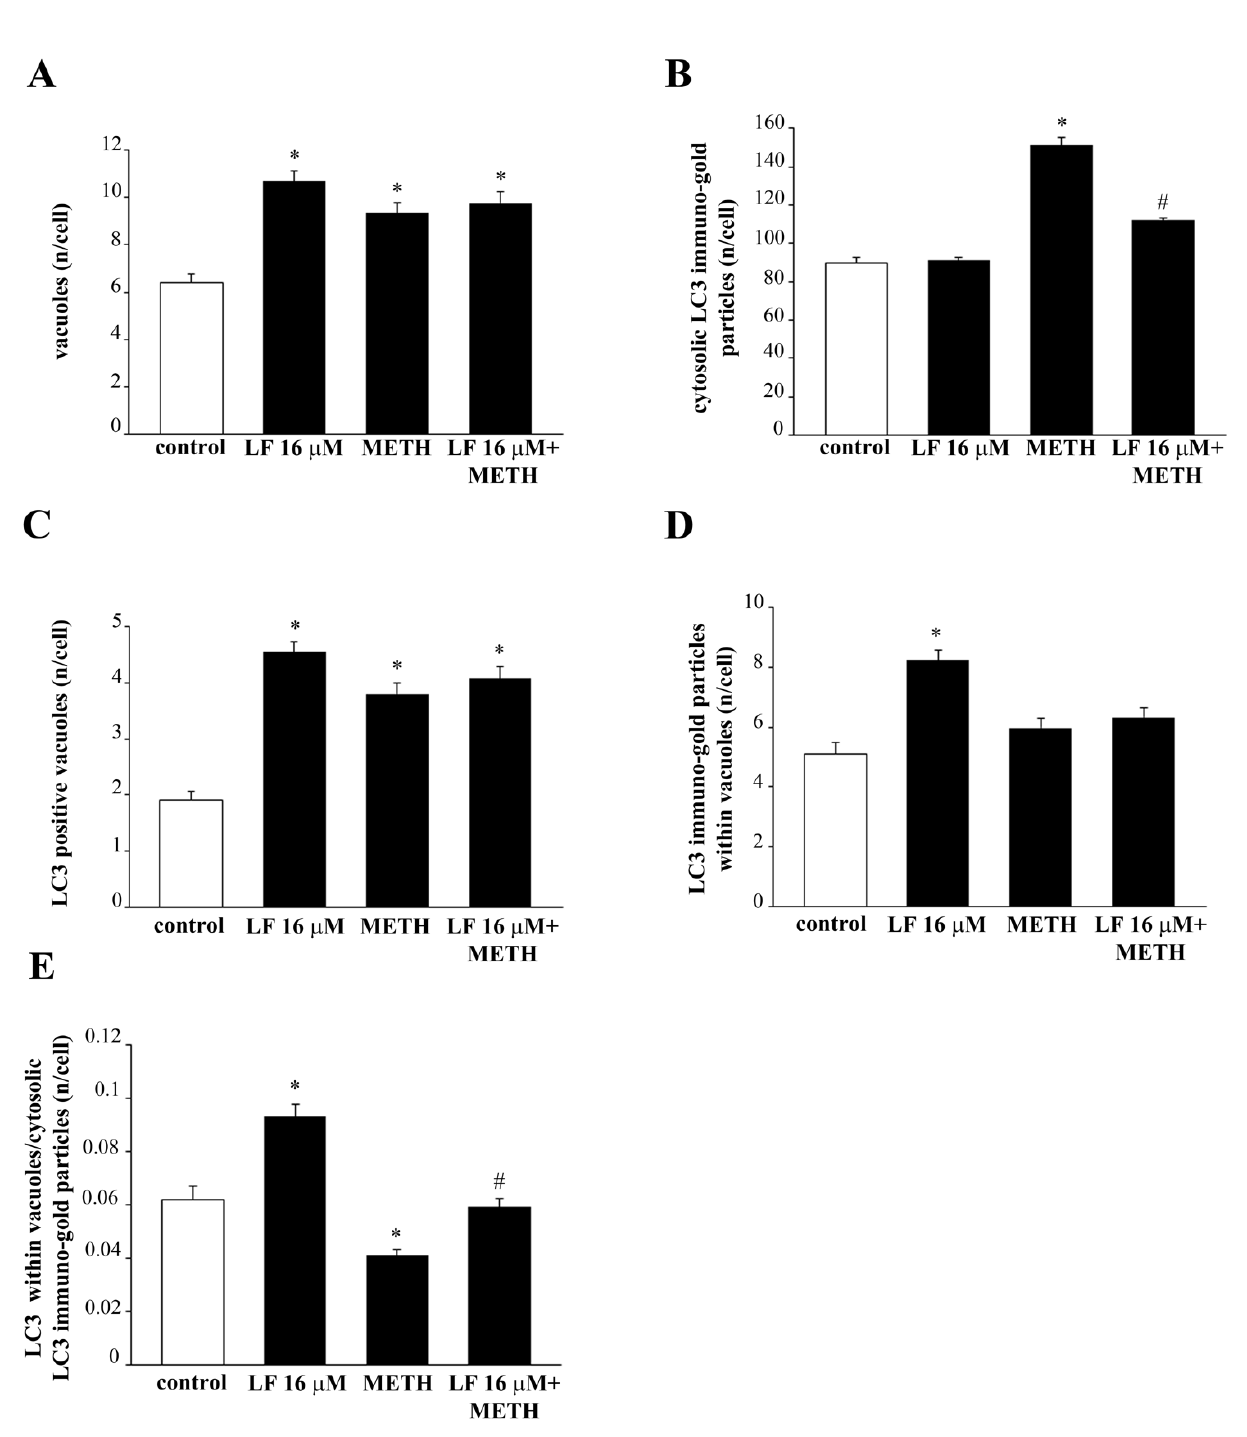
Figure 12. LF increases LC3 compartmentalization within vacuoles. Quantitative ultrastructural morphometry for LC3 is reported in the graphs ( A – E ). * p < 0.05 compared with control; # p < 0.05 compared with METH.